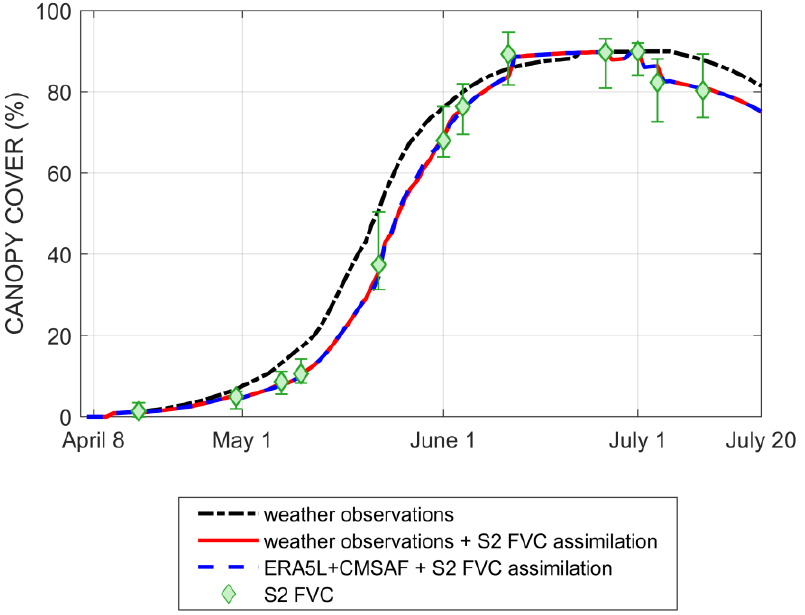
Figure 7. Canopy cover evolution for different model inputs, as described in the legend.